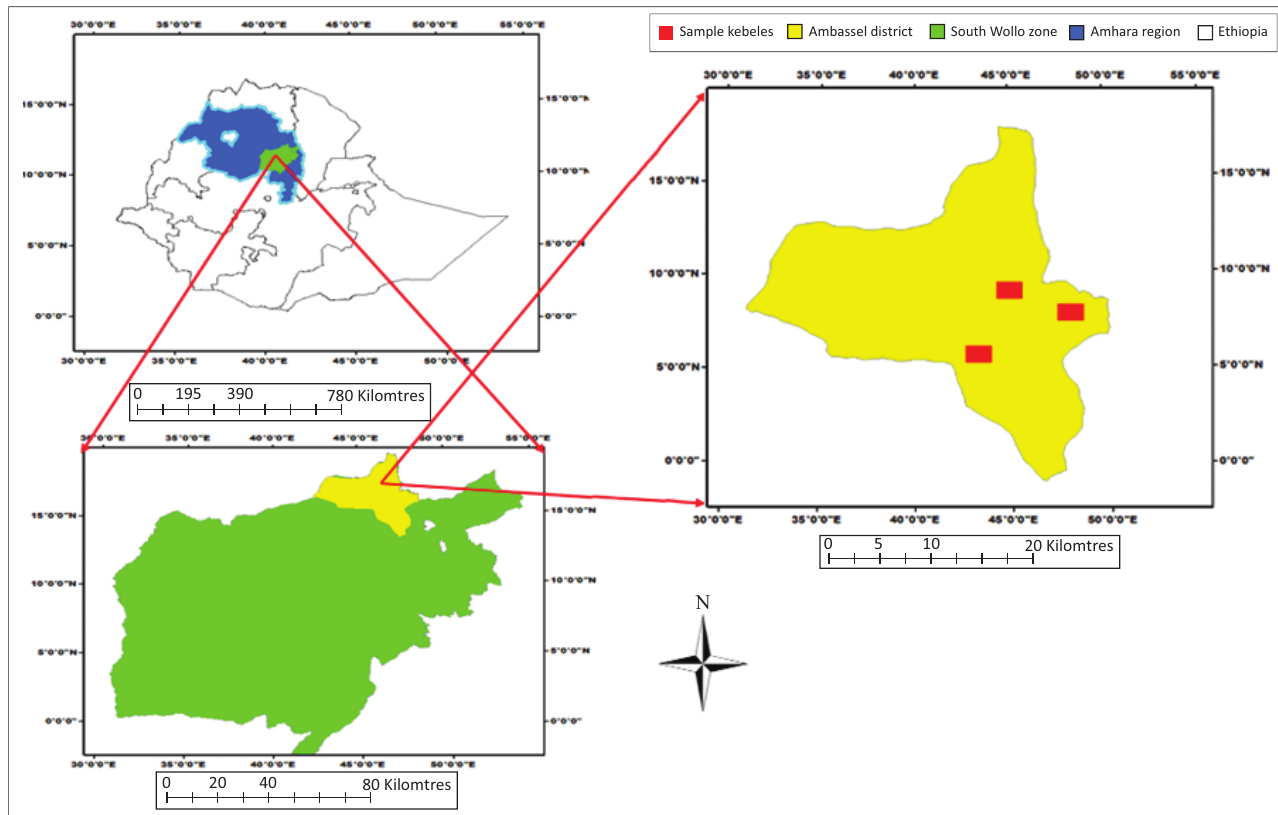
FIGURE 1: Map of the study